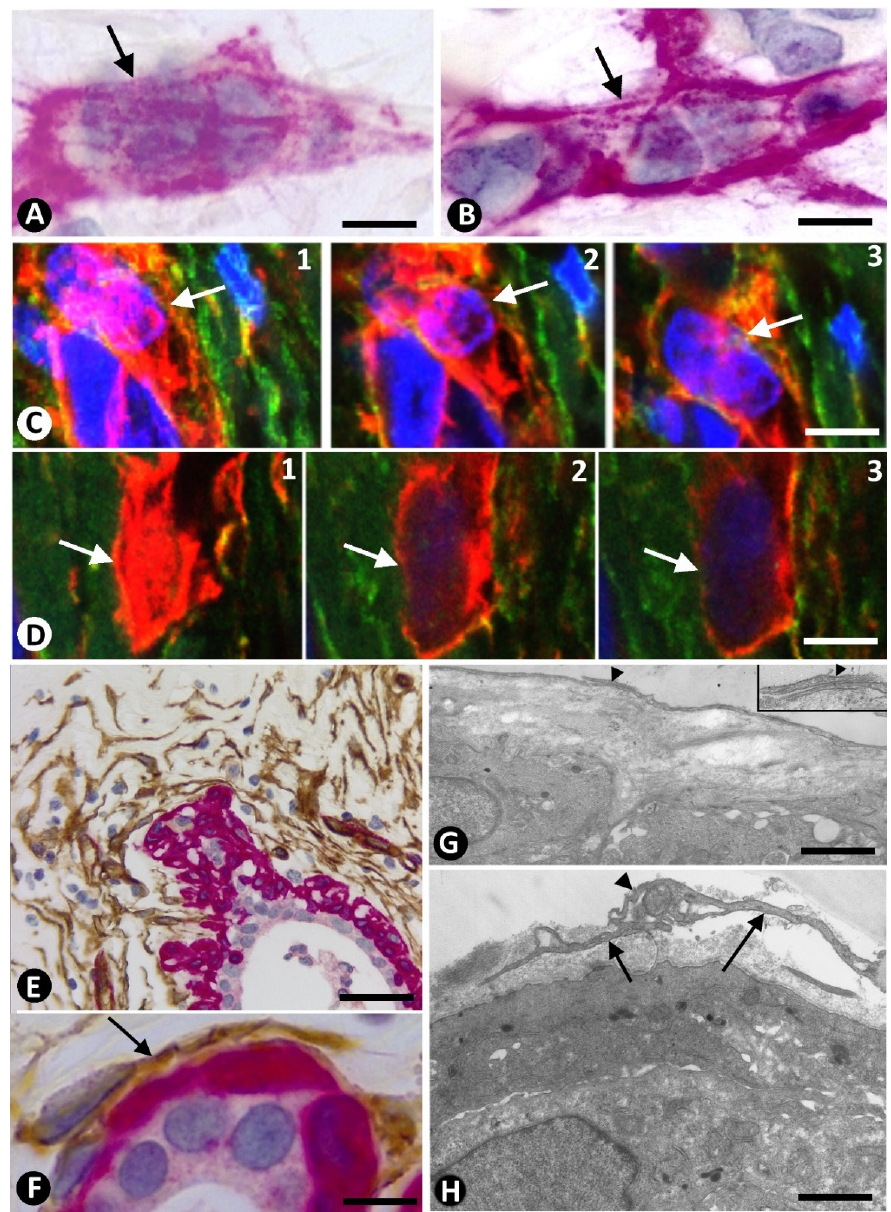
Figure 3. ( A , B , E , F ): Double immunochemistry for CD34 (brown) and α SMA (red). Haematoxylin counterstain. ( C , D ): Double immunofluorescence labelling for CD34 (green) and α SMA (red). DAPI counterstain. ( G , H ): Ultrathin sections. Uranyl acetate and Lead citrate. ( A – D ): Processes of α SMA+ stromal cells (red) forming veils (arrows) that cover neoplastic cells (blue stained nuclei) (in ( A , B ), sections parallel to the surface of the processes; in ( C , D ), individual visions at different heights in confocal microscopy, using tissue sections of 10µm). ( E ): Several layers of CD34+SCs/TCs (brown) around a normal breast duct in which the external layer of myoepithelial cells expresses α SMA (red). ( F ): One CD34+SC (brown, arrow) is observed around myoepithelial cells (red) of a component of the terminal ductal-lobular unit. ( G , H ): Ultrastructural images of long, thin telocyte extensions (telopodes) with podomeres (H arrows) and podoms (arrowhead) around ductal myoepithelial cells. Insert of ( G ) shows a contact between telopodes (arrowhead). Bar: ( A – D ): 8 µm; ( E ): 30 µm; ( F ): 20 µm; ( G , H ): 4 µm.